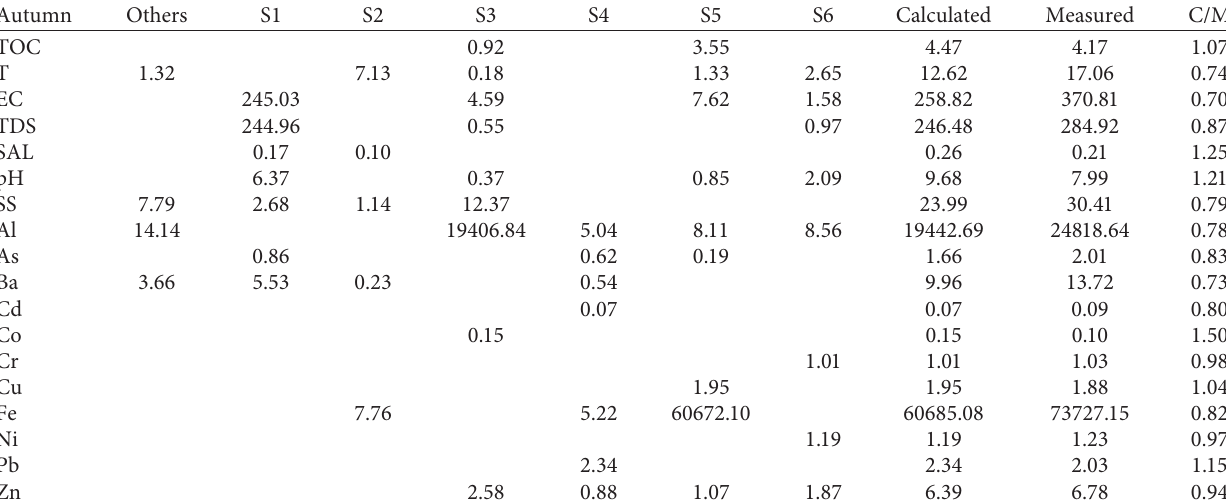
Table 6: Source apportionment for physicochemical parameters and heavy metals in autumn. Autumn